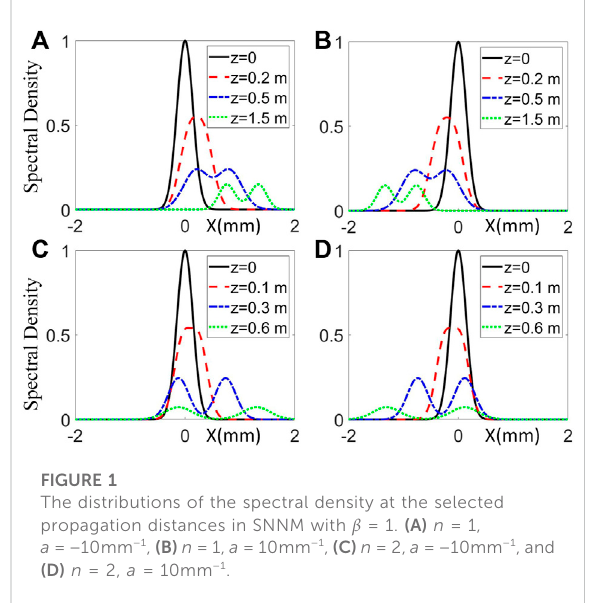
FIGURE 1 The distributions of the spectral density at the selected propagation distances in SNNM with β = 1. (A) n = 1, a = − 10mm − 1 , (B) n = 1, a = 10mm − 1 , (C) n = 2, a = − 10mm − 1 , and (D) n = 2, a = 10mm − 1 .